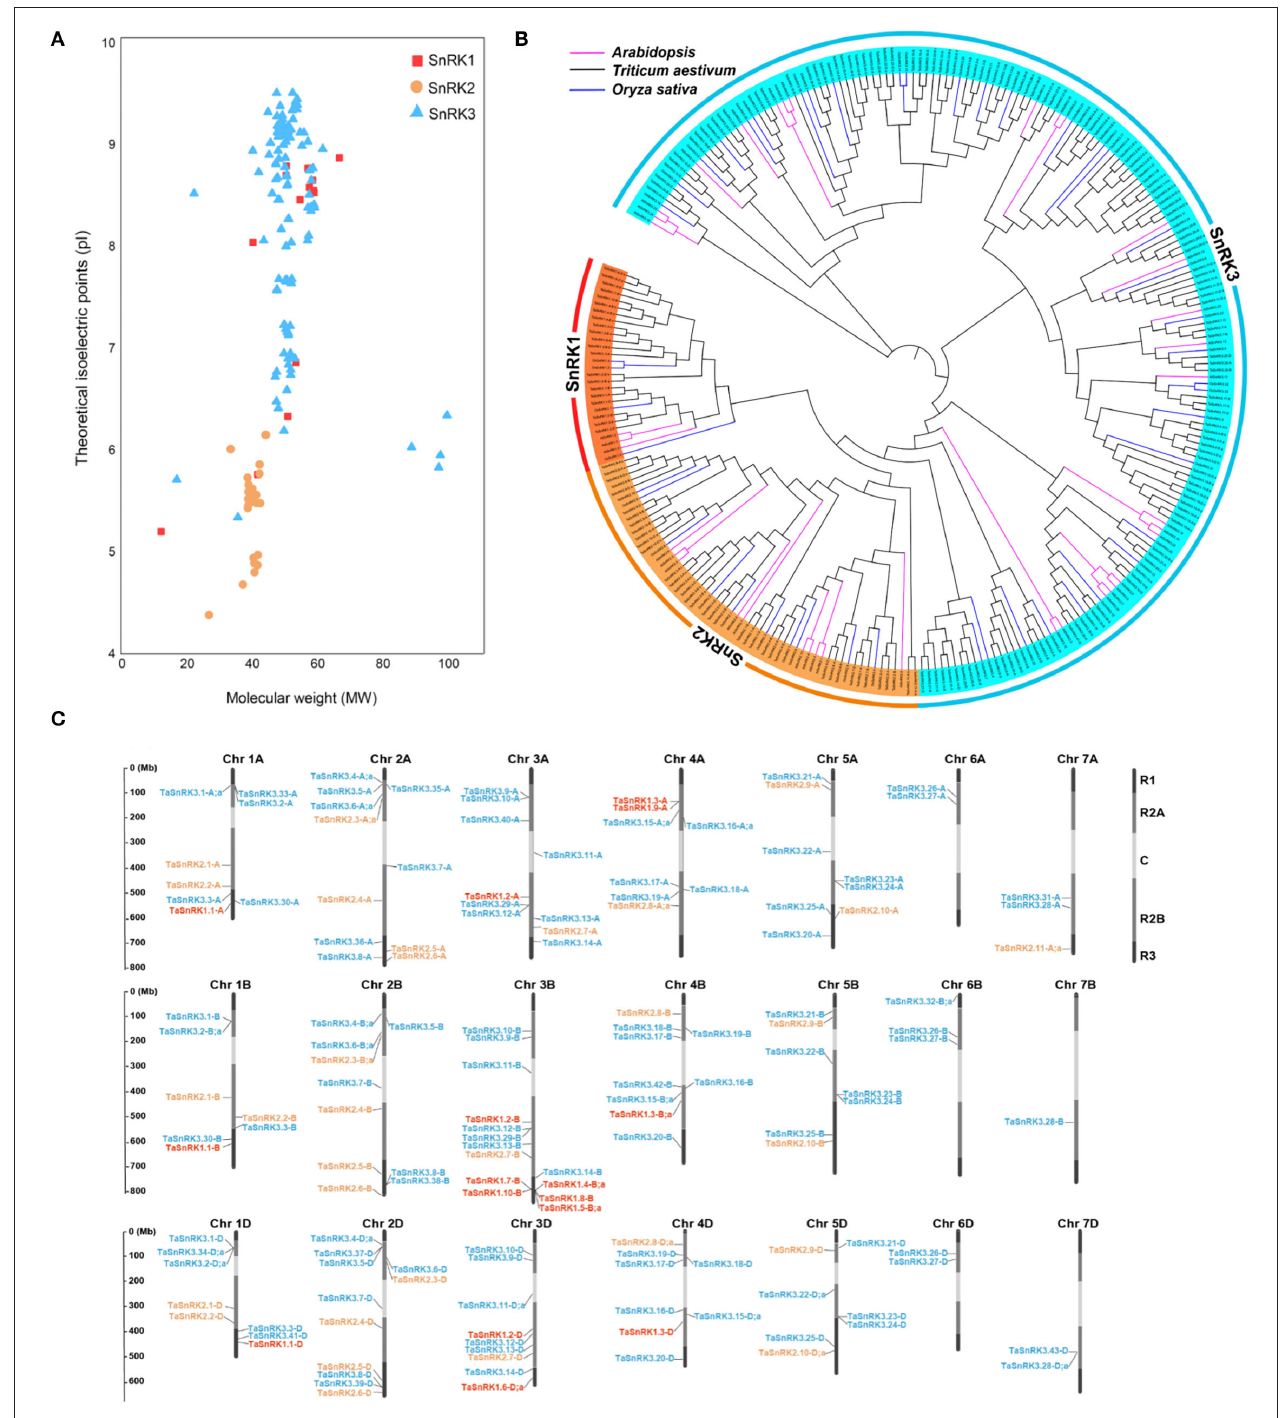
FIGURE 1 | General information of TaSnRKs. (A) The distribution patterns of isoelectric points (pI) and molecular weights (MW) for the three subfamilies of wheat SnRKs. (B) Phylogenetic tree of non-fermenting-1-related protein kinase (SnRK) predicted in wheat and those previously identified in Arabidopsis and Oryza sativa . All amino acid sequences, including 186 TaSnRKs, 47 OsSnRKs, and 38 AtSnRKs, were aligned using ClustalW2, and the phylogenetic tree was constructed using the bootstrap neighbor-joining method (NJ) tree (1,000 replicates) method and MEGA 7.0 software. Different color ribbons mark different sub-families. SnRKs from wheat, rice, and Arabidopsis are distinguished with different color lines. (C) Chromosomal locations of the 148 TaSnRK genes. The ruler line on the left indicates the physical map distance among genes (Mbp). Dark black represents R1 and R3 (distal telomeric parts of the chromosomes), light gray represents R2A and R2B (sub-central segments of the chromosomes), and white represents C (central segments of the chromosomes). Gene members of SnRK1 (red), SnRK2 (orange), and SnRK3 (blue) were mapped to corresponding chromosomes. TaSnRK3.44-U gene was not mapped in chromosomes because it was not predicted in any chromosomes. The specific location information of each gene on the chromosomes is listed in Supplementary Material 2